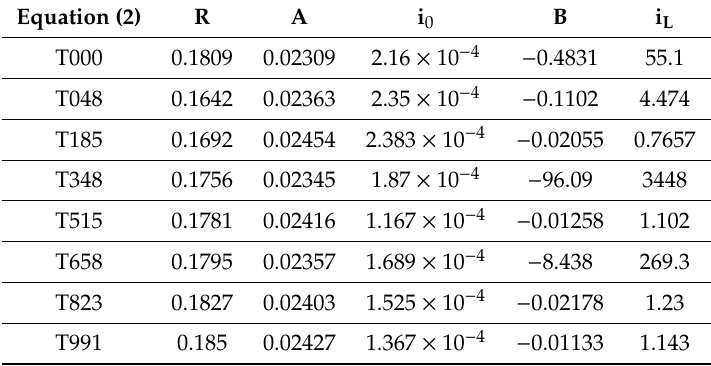
Table 4. Fitted model parameters in Equation (2).